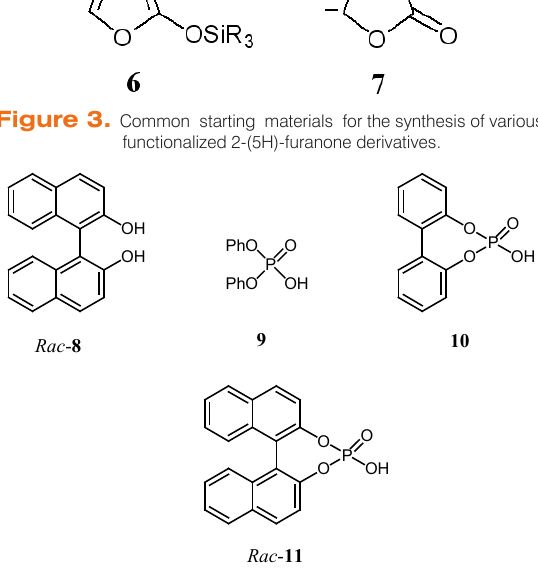
Figure 4. Phenol and BINOL-based phosphoric acids.